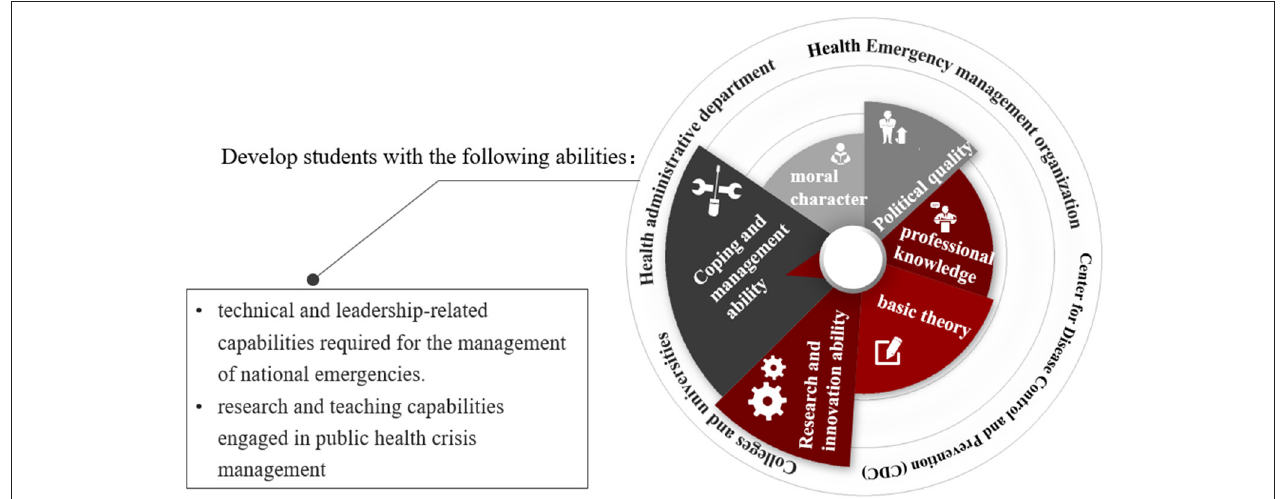
FIGURE 1 | Education objectives of DrTP-PHCM.